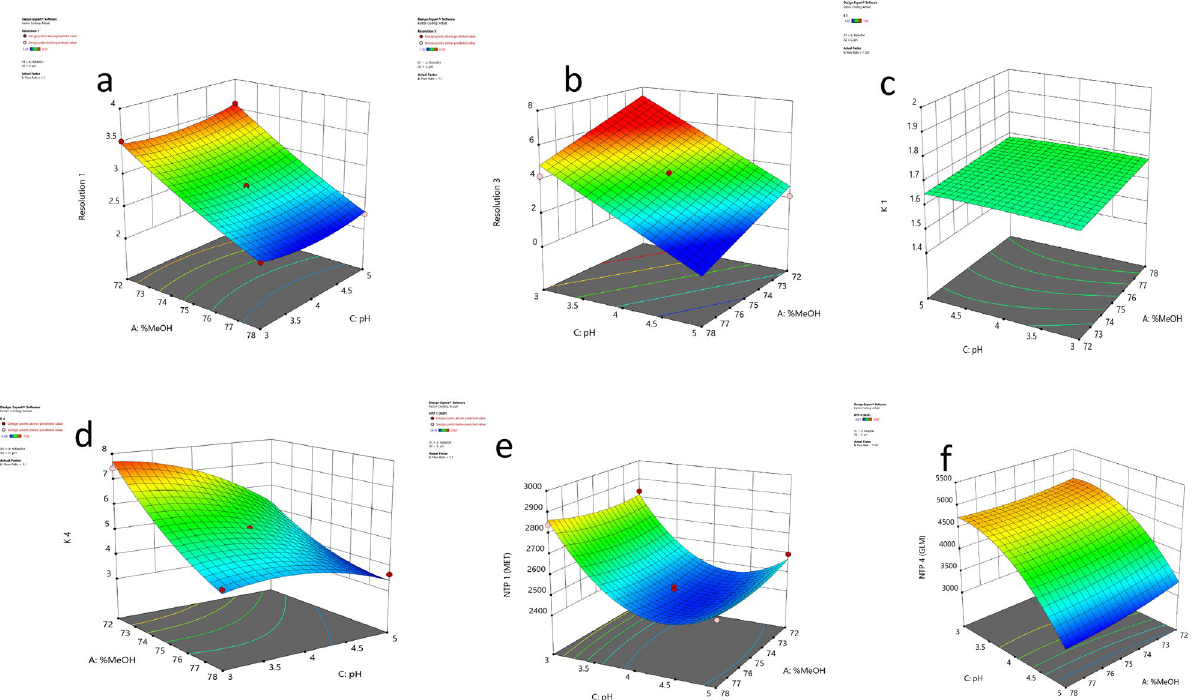
Figure 2. Response surfaces Box–Behnken design (BBD) for factor